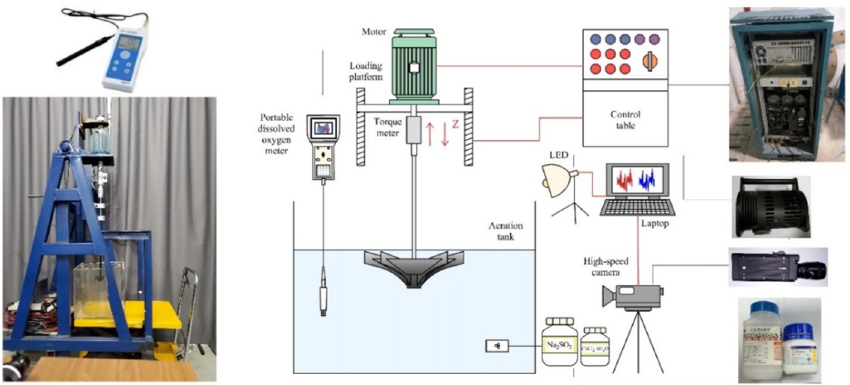
Figure 2. The schematic diagram of the test system. Table 1. Detailed description of the portable dissolved oxygen